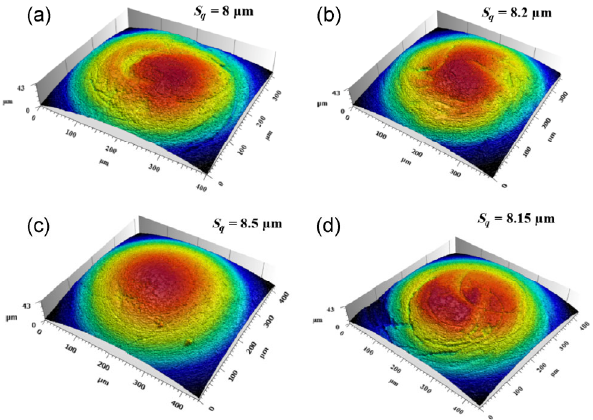
Fig. 3 Surface maps of four unworn hemispherical pin surfaces (a) pin surface 1, P1, (b) pin surface 2, P2, (c) pin surface 3, P3, and (d) pin surface 4, P4.